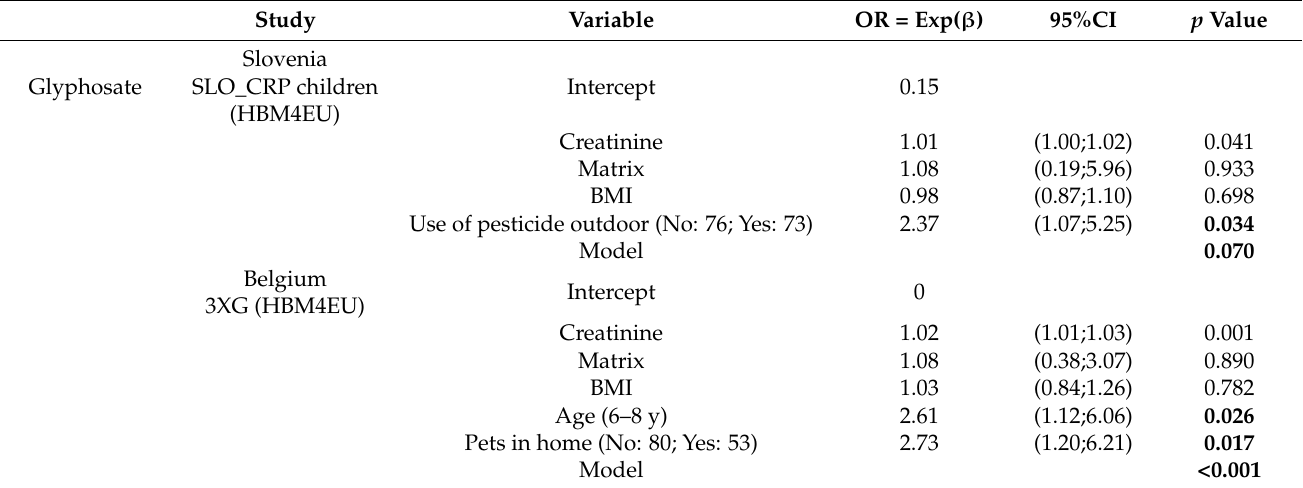
Table 5. Logistic backward multiple regression for glyphosate and AMPA based on individual studies from